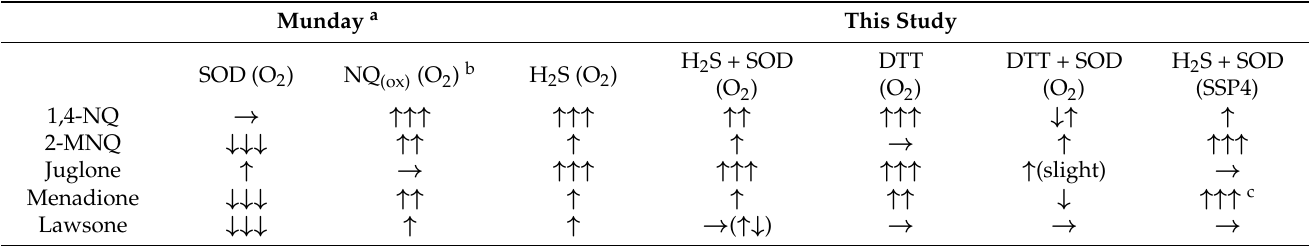
Table 3. Comparison of the relative rates of oxygen consumption (O 2 ) during autoxidation of NQs under various conditions from Munday a and this study. Right column shows polysulfide production (SSP4 fluorescence) by SOD with NQ and H 2 S. a, [40]; b, addition of corresponding oxidized NQ; c, [18]. Up arrows indicate degree of increase, horizontal arrow indicates no change and down arrows indicate degree of